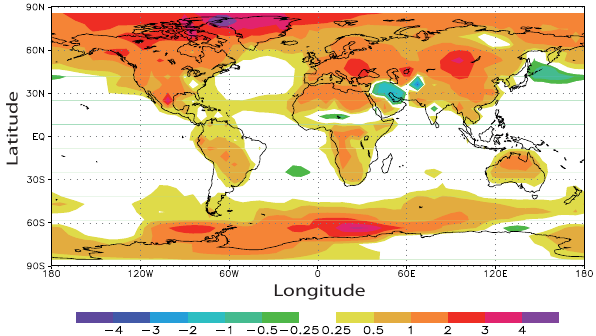
Fig. 18 Simulated difference of summer (JJAS) temperature (in °C) between the mid- Fig. 18. Simulated difference of summer (JJAS) temperature (in ◦ C) between the mid-Holocene and present-day conditions. Holocene and present-day conditions.